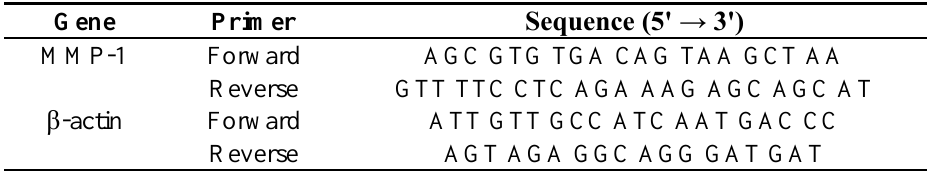
Table 1. Sequence information of primers used for